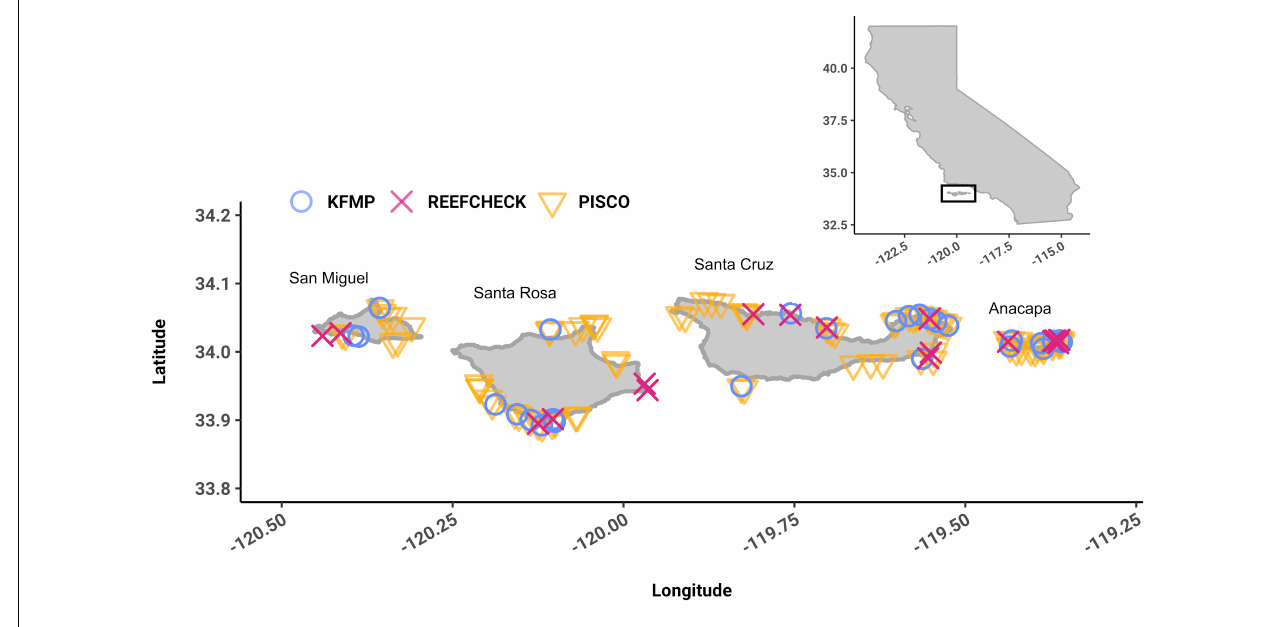
FIGURE 1 | Sites sampled in the Channel Islands National Park, California, United States.